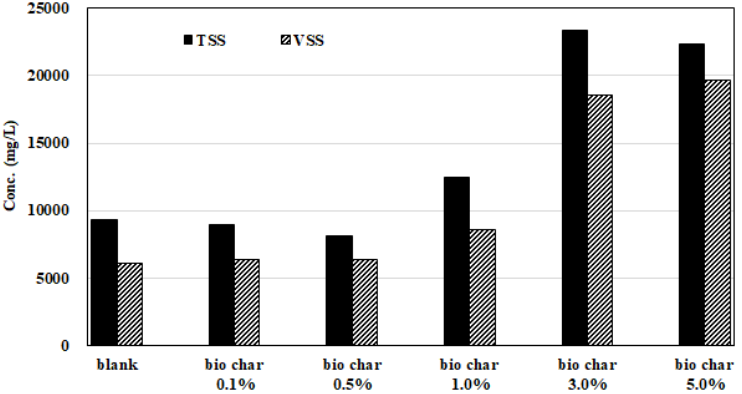
Figure 4. Total suspended solids (TSS) and volatile suspended solids (VSS) before and after the biochemical methane potential test.